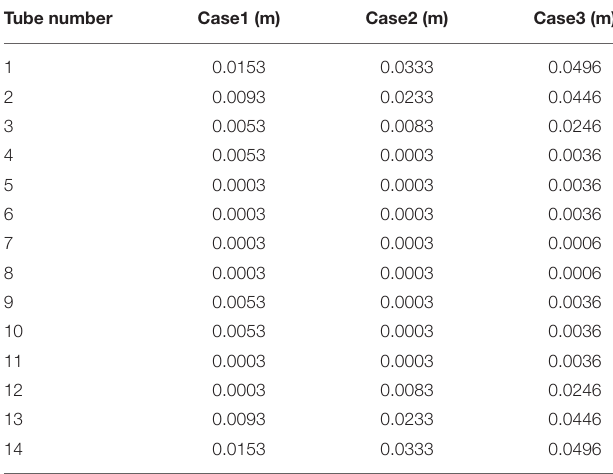
FIGURE 7 | Configuration of a dividing flow manifold.